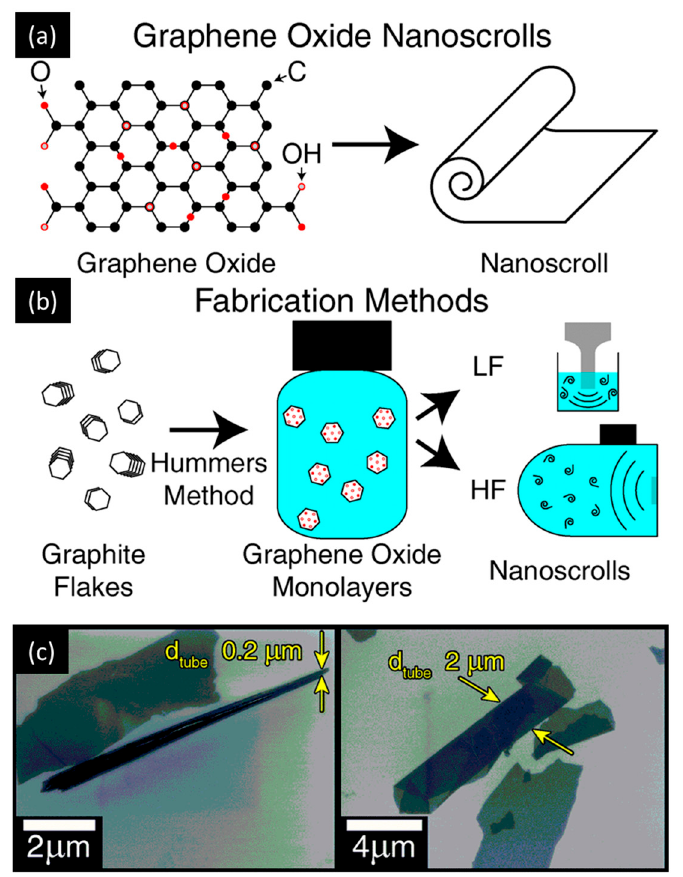
Figure 2. Structure and fabrication methods of GO and GO-NHSs. ( a ) Illustration of the GO-NSH chemistry showing the arrangement of the oxygen functional groups, and the cross-sectional morphology of GO-NSCs. ( b ) Summary of the GO-NSH fabrication process starting from graphite flakes and demonstrating the difference between the low-frequency (LF) and high-frequency (HF) processing. ( c ) Morphology of GO-NSHs: SEM displaying narrow and wide tube-like GO-NSCs that are characterized by their diameters (d tube ). Adapted from Ref. [62].